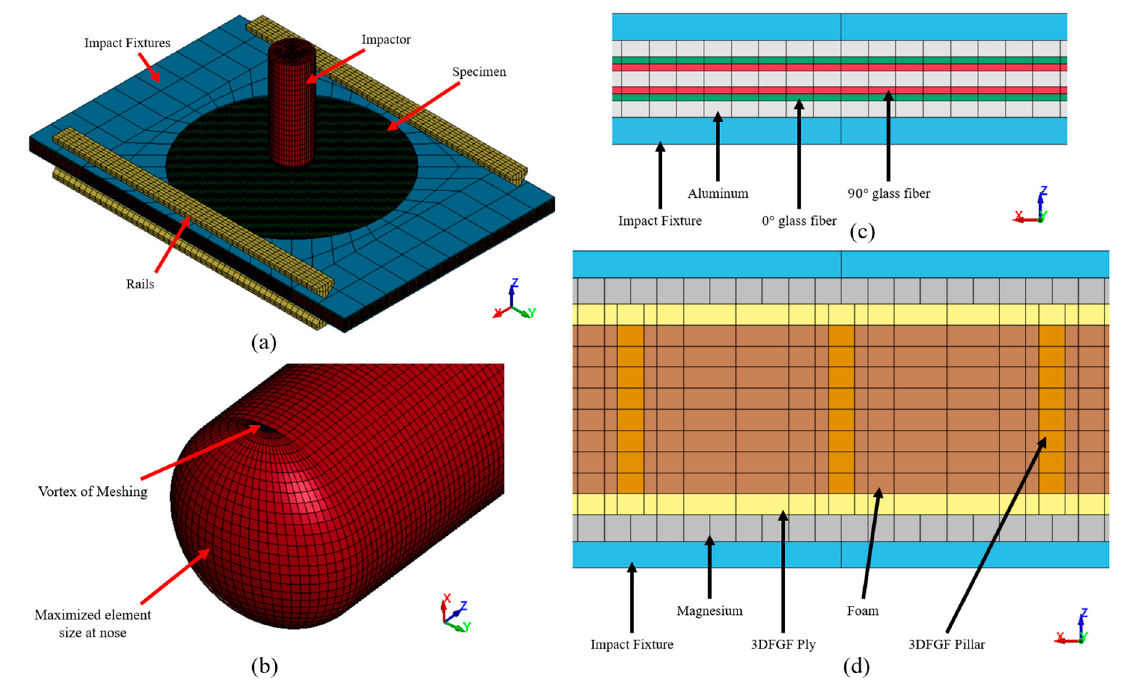
Figure 5. Numerical model: ( a ) overall model layout; ( b ) mesh of the impactor nose; cross-section mesh of ( c ) GLARE and ( d ) 3DFML.